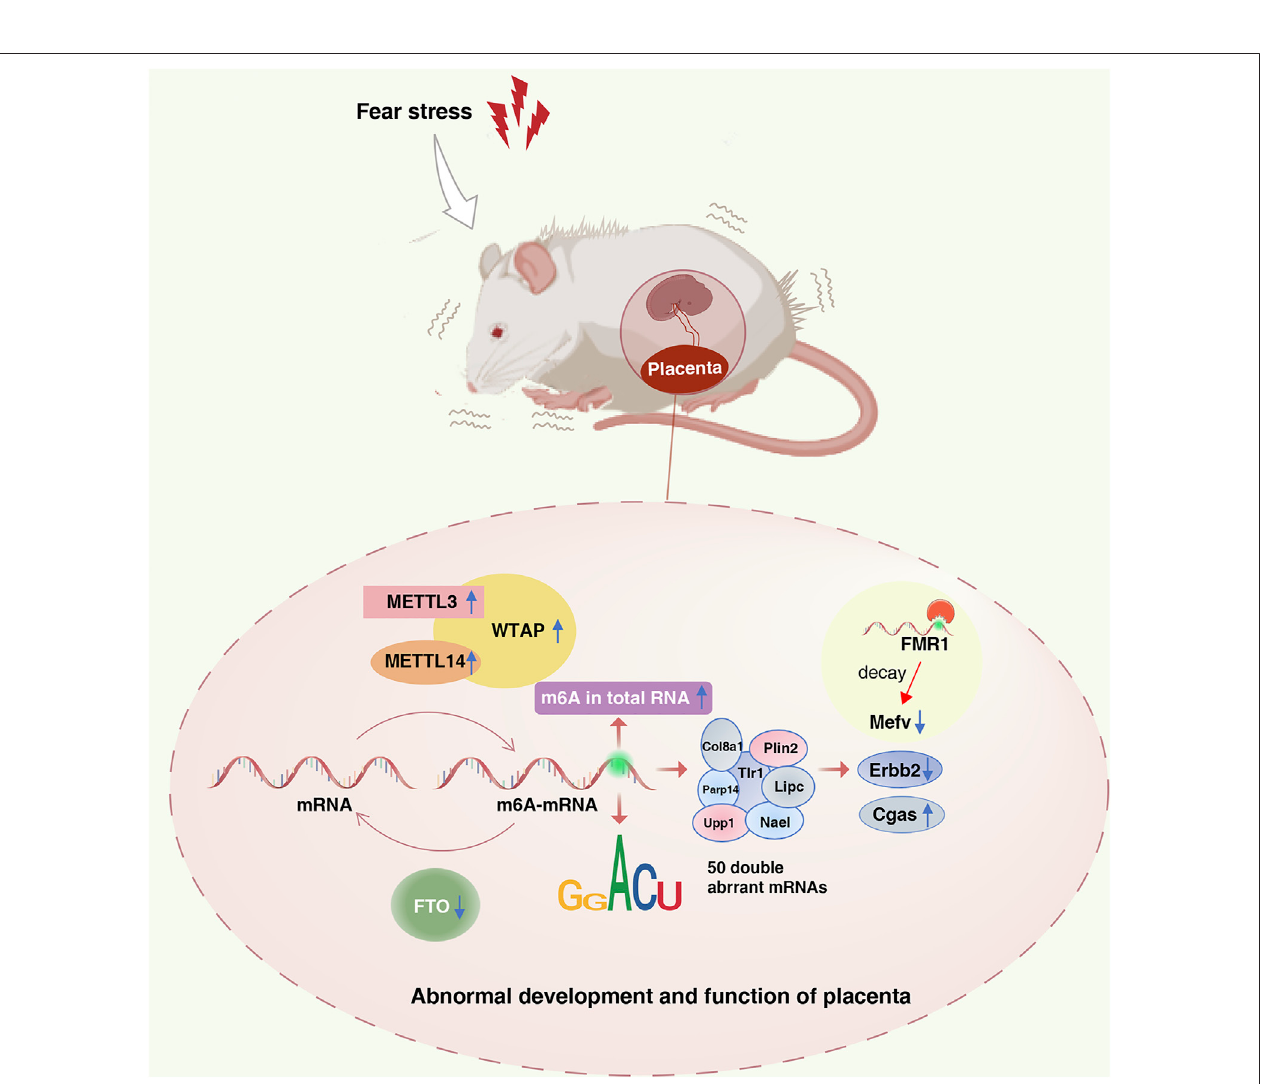
FIGURE 8 | Role of the m6A modi fi cation in placental dysfunction induced by fear stress during pregnancy. Fear stress during pregnancy increases the levels of methylatedenzymes(METTL3, METTL14,andWTAP),decreasesthelevelsofdemethylaseFTO,andincreasestheoverallmethylationlevelsintheplacentaofpregnant rats. Fear stress during pregnancy can lead to abnormal modi fi cation and differential expression of 50 genes. Decreased expression of Mefv may rely on the decay function of m6A modi fi c.